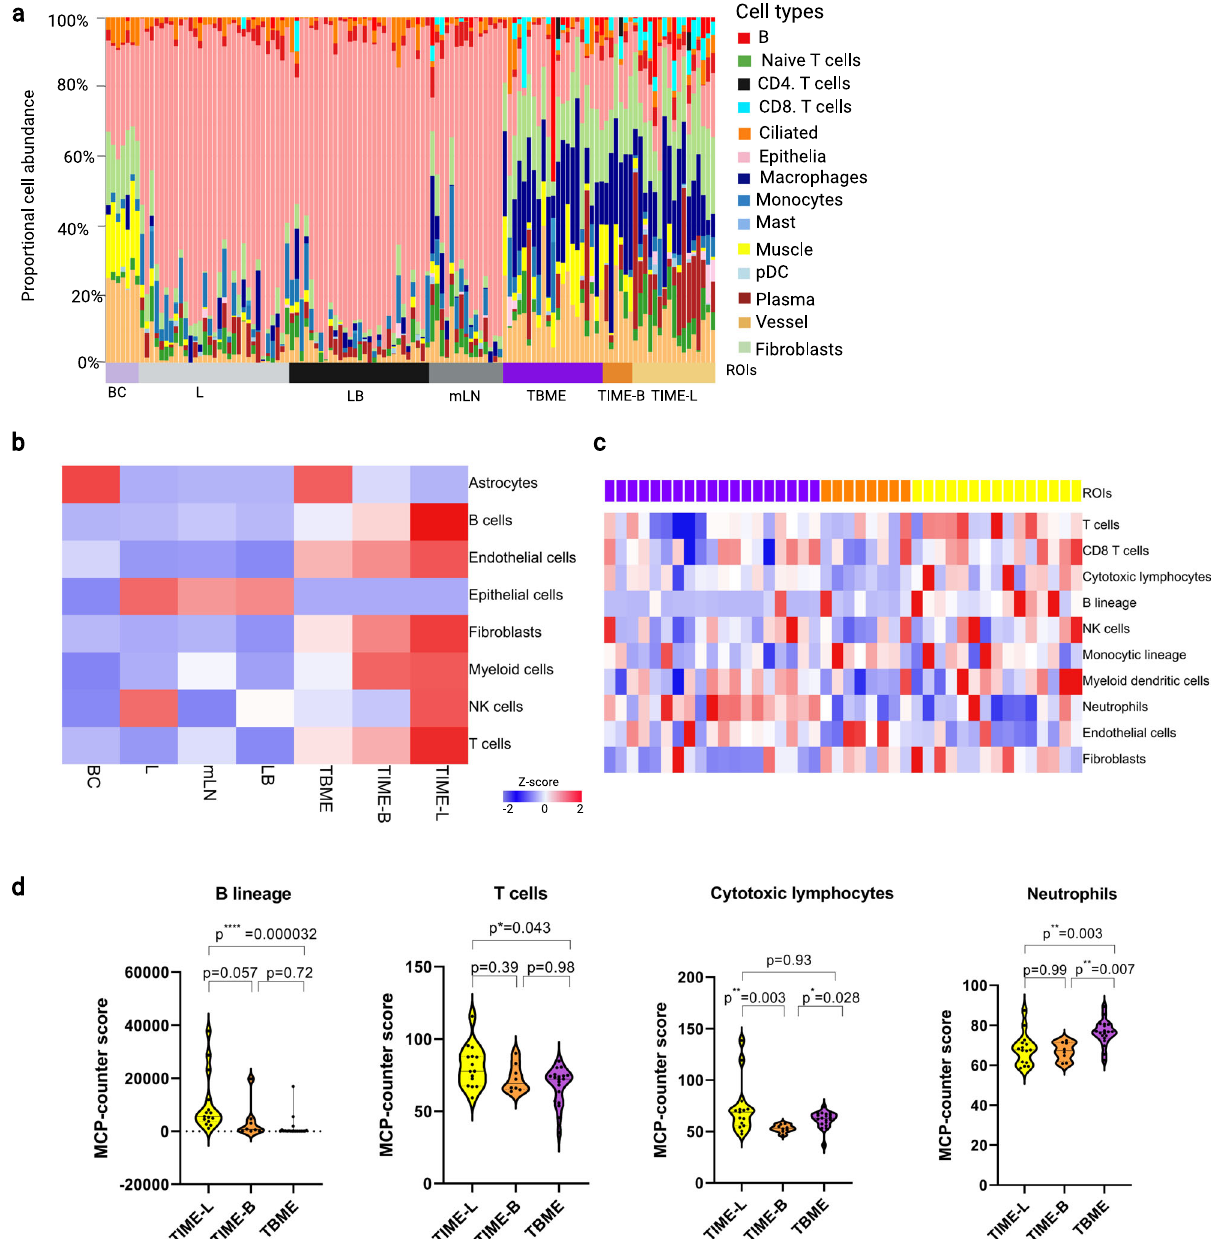
Fig. 2 | Spatial speci fi city of cellular composition and gene expression in the primary tumor and metastases. a ROI-speci fi c deconvolution of cell populations based on the corresponding bulk RNA-Seq data by SpatialDecon. Related ROIs are groupedtogether and identi fi ed onthe x axis. b Deconvolution ofcellpopulations by Qlucore Omics Explorer based on average gene expression in the indicated groups. c Cell deconvolution of the TME by MCP-Counter. d Violin plots showing the differences in the indicated cell types between the TIME-L, TIME-B, and TBME.